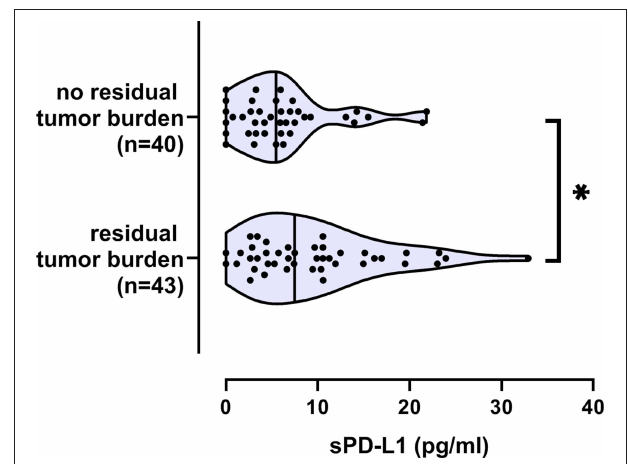
reverse-transcription (RT) and multiplex RT-PCR, detecting EpCAM, MUC-1, and CA-125 (AdnaTest OvarianCancerDetect ). ERCC1-transcripts were studied by a singleplex RT-PCR ( n = 57/83 patients). β -actin served as an internal control. Assays have been described in detail elsewhere (15, 16).